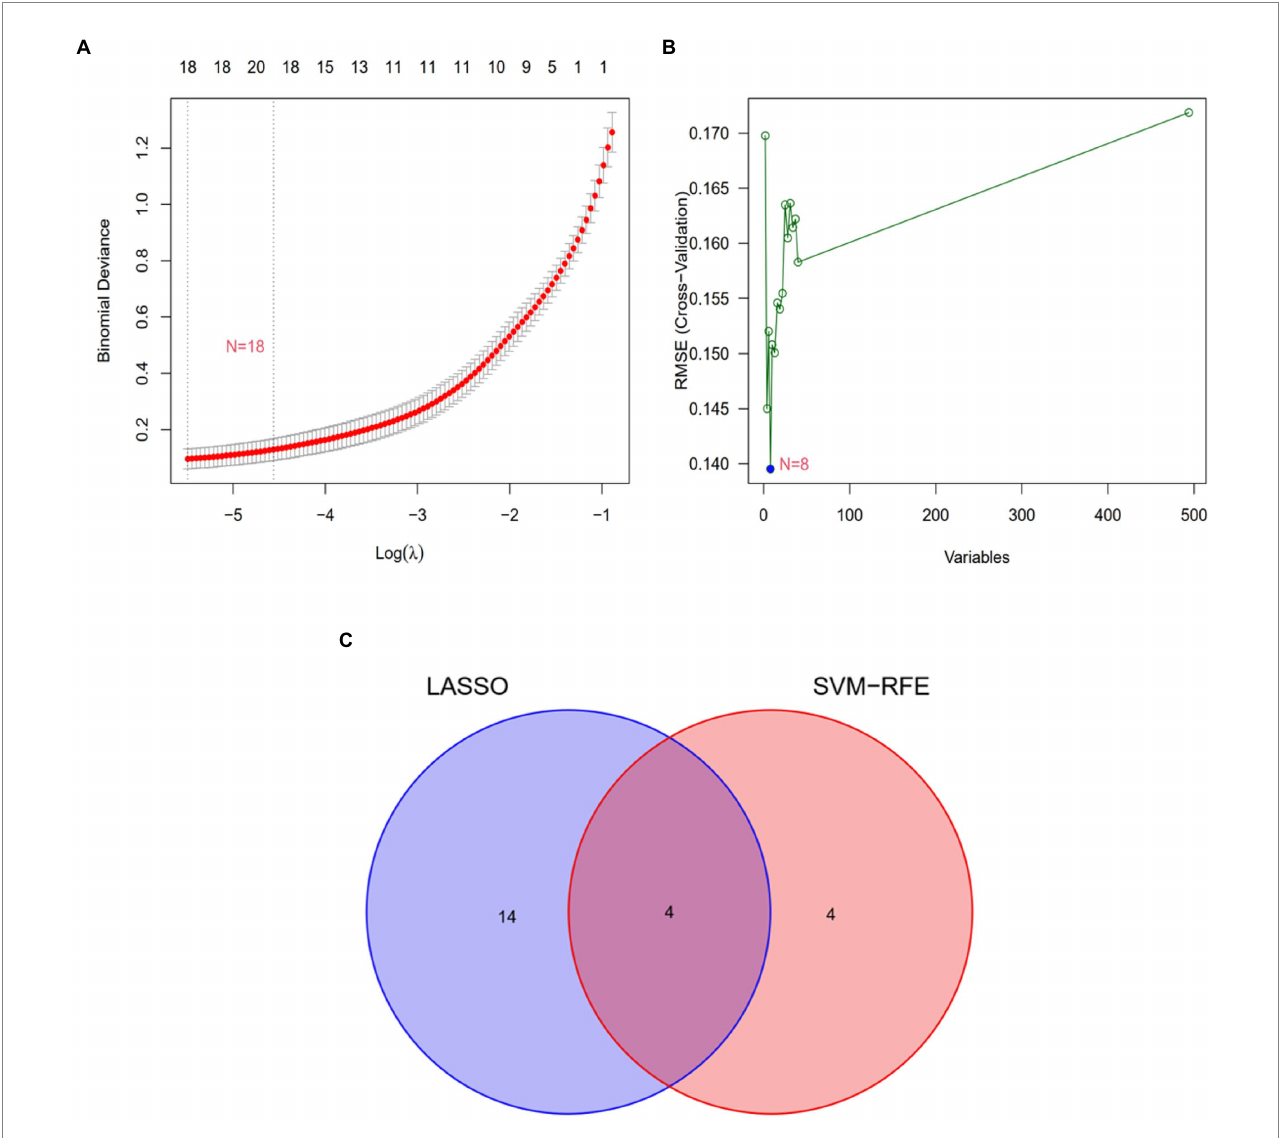
FIGURE 3 Screening of candidate gene biomarkers using two machine learning algorithms. (A) Tuning feature selection using the LASSO algorithm. (B) A plot of biomarker selection using the SVM-RFE algorithm. (C) Venn diagram demonstrating the four diagnostic markers (COL3A1, CDH3, CEBPD, and GPIHBP1) shared by the LASSO and SVM-RFE algorithms.